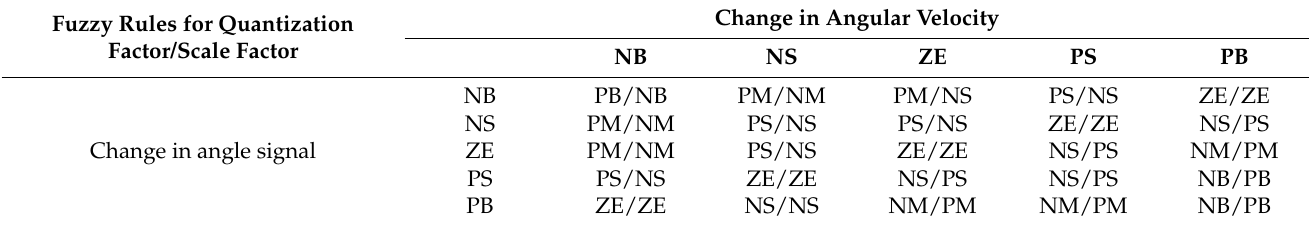
Figure 11. Membership function curve of fuzzy self-tuning control: ( a ) quantization factor k z 1 ; ( b ) quantization factor k z 2 ; ( c ) scale factor k uo . Table 4. Fuzzy control rules of quantization factor/scale